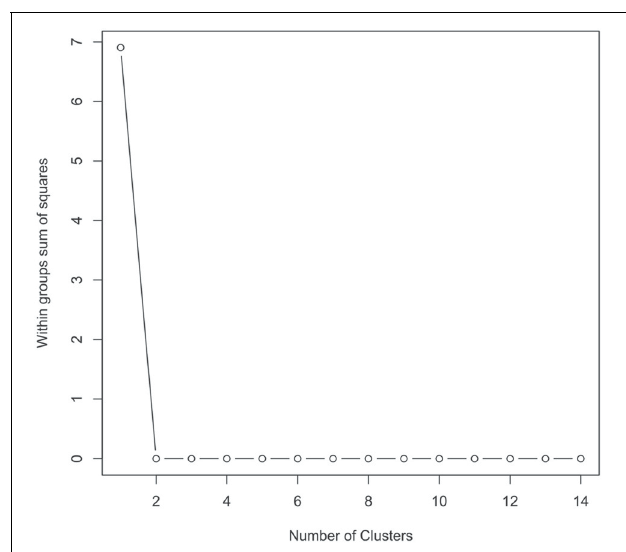
FIGURE A1 | Graphical view of the results of the partitioning around mediods (PAMK in R) used to determine the number of clusters in the urinary microbiome datasets. In this instance two clusters were identified as being the optimal